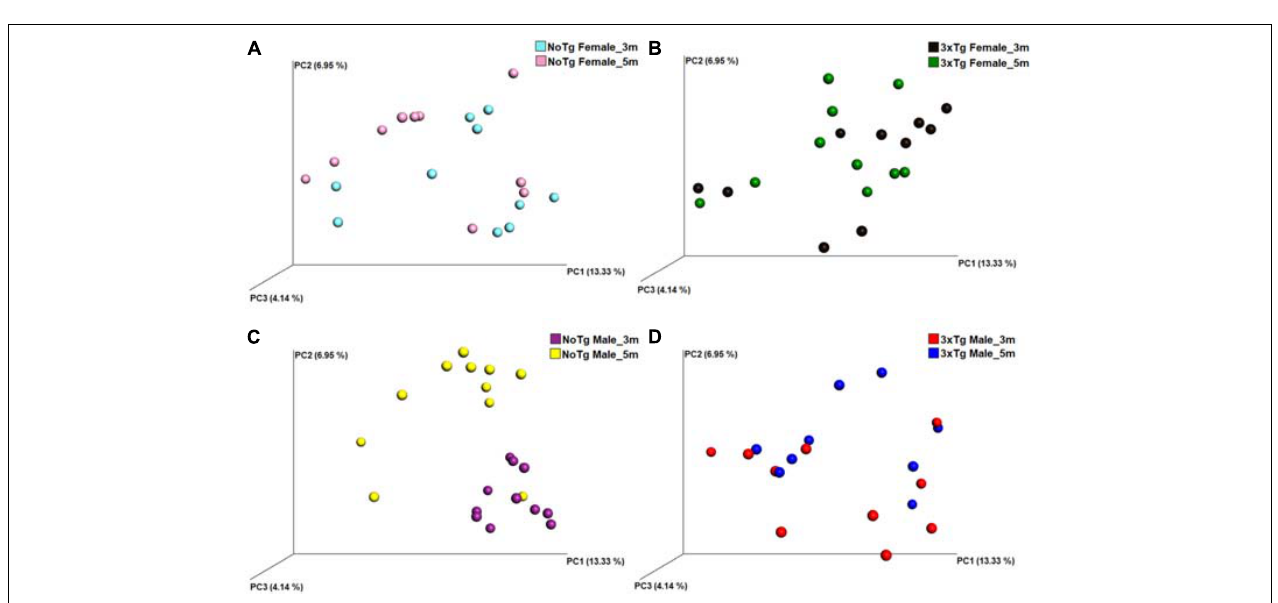
FIGURE 9 | Beta diversity of bacteria in fecal samples collected from non-transgenic (NoTg) and Alzheimer’s disease triple-transgenic (3xTg-AD) mice. The graphics show beta diversity analyses calculated by dissimilarity metrics using operational taxonomic unit (OTU) tables and Unweighted UniFrac analyses. The analyses show the dissimilarity among mice by colors: NoTg female at 3 months (m) old (cyan), 3xTg-AD female at 3 months old (black), NoTg female at 5 months old (pink), 3xTg-AD female at 5 months old (green), NoTg male at 3 months old (purple), 3xTg-AD male at 3 months old (red), NoTg male at 5 months old (yellow), 3xTg-AD male at 3 months old (blue). Data comparisons by time in the same genotype: NoTg female mice 3 and 5 months old (A) , 3xTg-AD female mice 3 and 5 months old (B) , NoTg male mice 3 and 5 months old (C) , and 3xTg-AD male mice 3 and 5 months old (D) . The three-dimensional scatter plots were generated using principal coordinates analyses (PCoA) in three different axis that show the percentage of total differences. There is a significant difference in panel (C) according to ANOSIM similarity test ( R = 0.425, p = 0.002) but not in panels (A) ( R = 0.032, p = 0.223), (B) ( R = 0.020, p = 0.297), and (D) ( R = 0.093, p = 0.076).